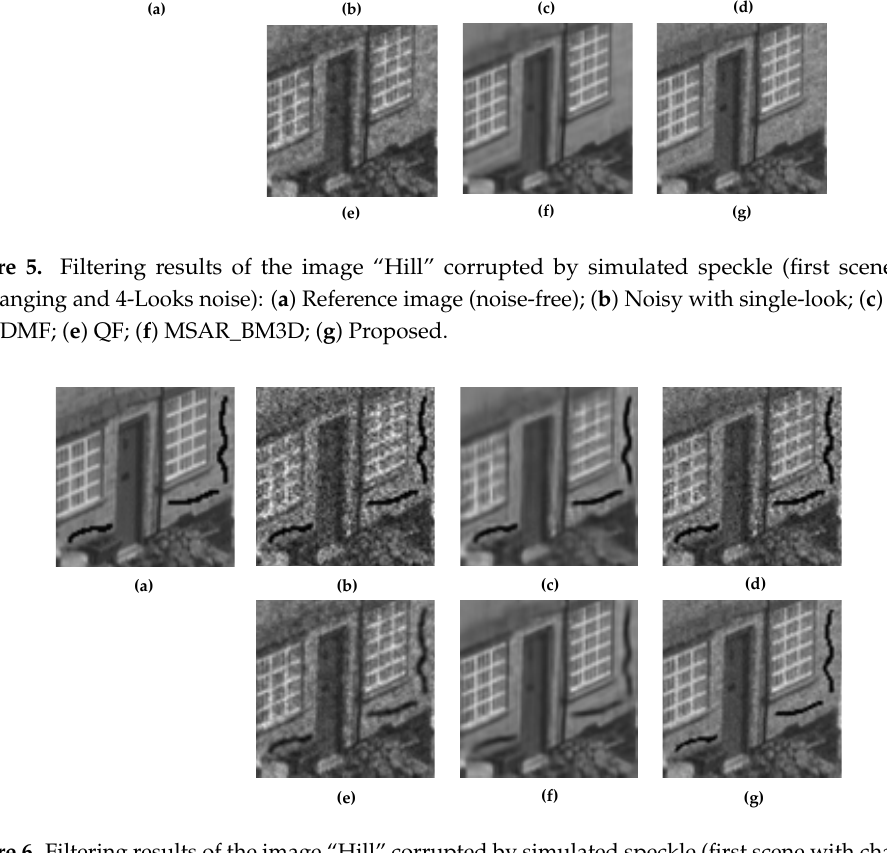
Figure 6. Filtering results of the image “Hill” corrupted by simulated speckle (first scene with changing and 4-Looks noise): ( a ) Reference image (noise-free); ( b ) Noisy with single-look; ( c ) FANS; ( d ) CDMF; ( e ) QF; ( f ) MSAR_BM3D; ( g ) Proposed. ( e ) QF; ( f ) MSAR_BM3D; ( g )